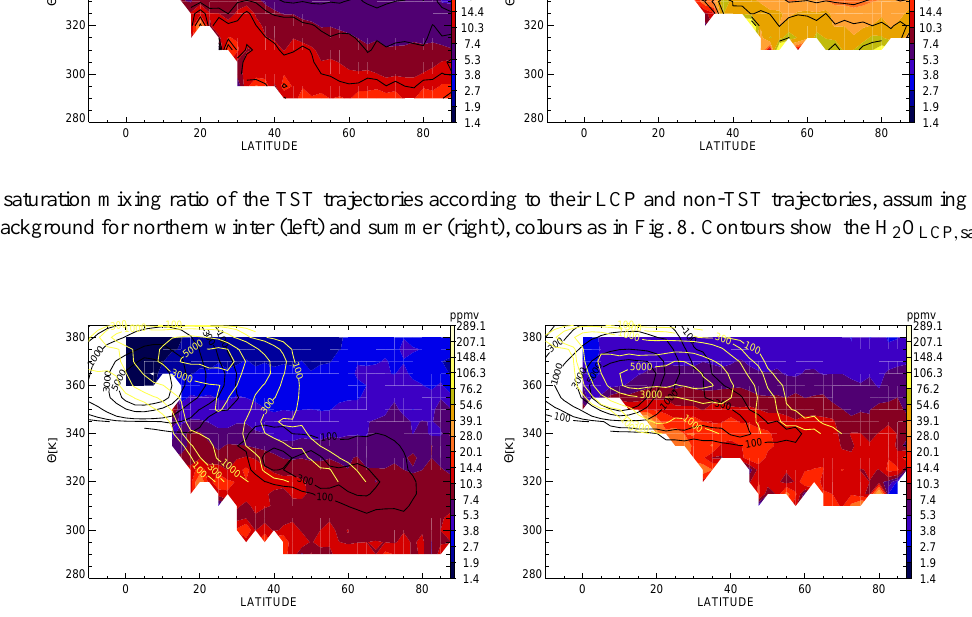
Fig. 10. Mean saturation mixing ratio from TST trajectories neglecting TST-events below Θ = 320 K (winter, left) and Θ = 340 K (summer, right), colours as in Fig. 8. Black and yellow contours indicate the locations of LCP and TST, respectively, for these subsets of TST trajectories (number in 2 . 5 ◦ × 5 K-bins).